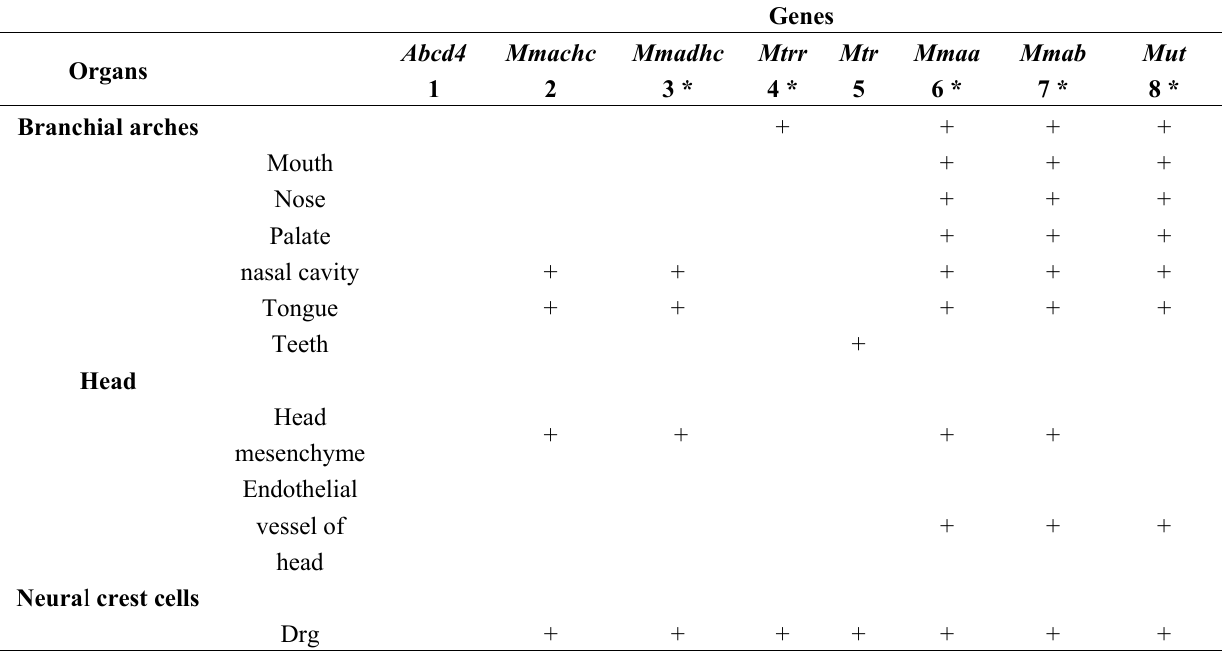
Table 1. Summary of the main sites of expression of genes in vitamin B12 absorption during mouse embryogenesis from E9.5–E14.5. 1 : only analyzed at E14.5; 2 : only analyzed at